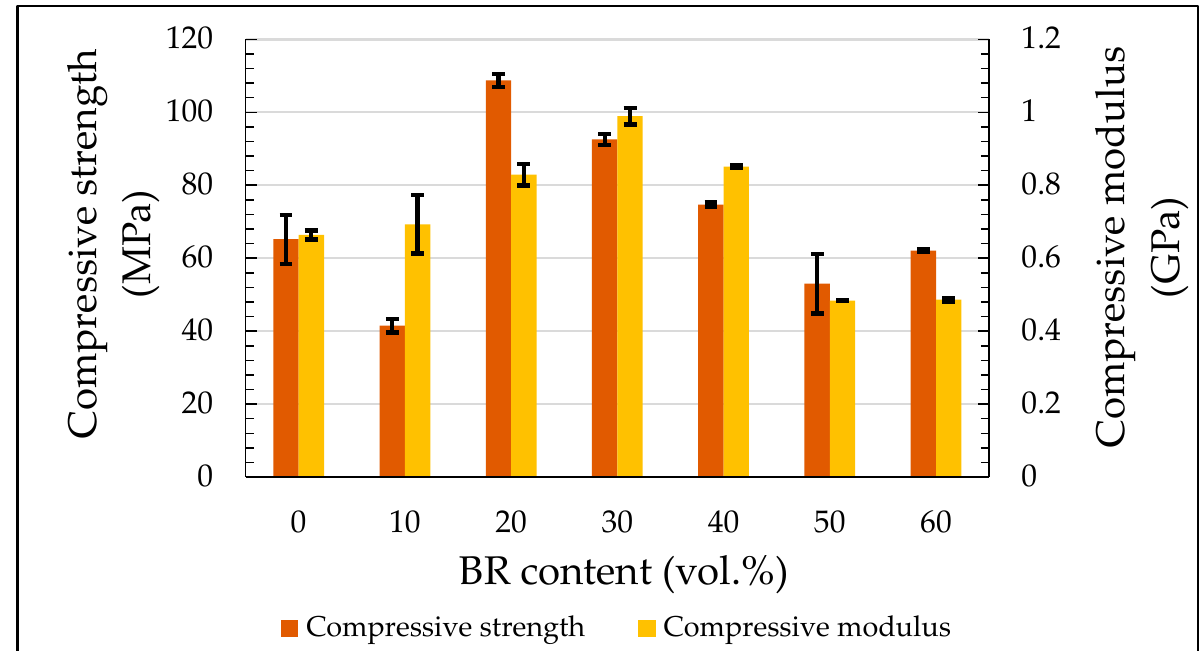
Figure 5. Effect of BR vol.% on the composite compressive strength and modulus of BR–UPR composites.